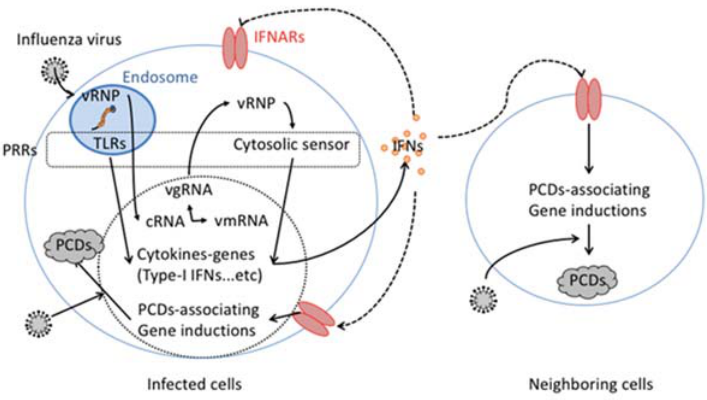
Figure 1. Cytokine ‐ dependent pogrammed cell death (PCD) induction in influenza virus infection. Figure 1. Cytokine-dependent pogrammed cell death (PCD) induction in influenza virus VRNP incorporated in influenza virus particles is released from the particle within the host cellular endosome. The released vgRNA that consists of vRNP engages host endosomatic pattern recognition receptors (PRRs), such as toll like receptors (TLRs). In the host cell cytosol, vRNP also activates cytosolic PRRs. The activation of both endosomatic and cytosolic PRRs stimulate gene induction of type ‐ I interferon (IFN). The secreted type ‐ I IFN binds and activates its specific receptor, IFNARs in an autocrine and paracrine manner. The activated IFNARs stimulate the gene induction of several PCD associated genes, including FasL or TRAIL.